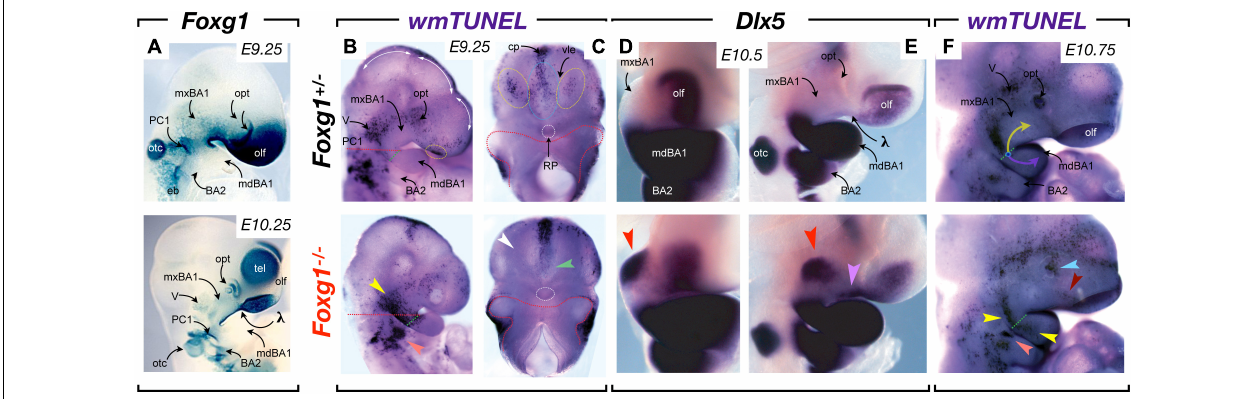
FIGURE 6 | Foxg1 , apoptosis, and control of upper jaw patterning and development. (A) Foxg1 expression, notable in mxBA1, FNP and hinge SCE, and absence in mdBA1, as assayed by X-gal staining due to β -galactosidase activity resulting from the insertion of a LacZ cassette in the Foxg1 locus. (B,C) Whole mount TUNEL assay of E9.25 Foxg1 + / − and Foxg1 − / − embryos. (B) Lateral view. Dotted red lines indicate planes of separation for (C) . Dotted green lines indicate the nascent hinge region. Dotted yellow circles indicate the normal foci of apoptotic cells in the medial olfactory fields of the SCE. Yellow arrowhead, extensive ectopic apoptosis connecting the trigeminal, the aboral border of mxBA1, and the hinge (including the oral ectoderm) evinced in null embryos. White arrowhead, loss of apoptotic foci in the medial olfactory fields of the SCE. Green arrowhead, loss in the ventral SEC below the closed anterior neuropore. (D,E) Frontal (D) and lateral (E) views of E10 Foxg1 + / − and Foxg1 − / − embryos highlighting the ectopic induction of Dlx5 (red arrowhead). A master regulatory gene for mdBA1 identity, expression in the mxBA1 demonstrates that Foxg1 acts to suppress the acquisition of lower jaw identity in the upper jaw developmental field. Lavender arrowhead, ectopic epithelial expression of Dlx5 . (F) Apoptosis in E10.75 Foxg1 + / − and Foxg1 − / − embryos. Yellow arrow, mxBA1 hinge signaling. Lavender arrow, mdBA1 hinge signaling. Dotted green line, oral-aboral axis at the hinge. Yellow arrowheads, alterations of mxBA1 apoptosis and expansion into mdBA1. Orange arrowhead, ectopic BA2 apoptotic foci. Light blue arrowhead, alteration of apoptosis in the lens pit. Dark red arrowhead, reorientation of apoptosis normally associated with the nasolacrimal